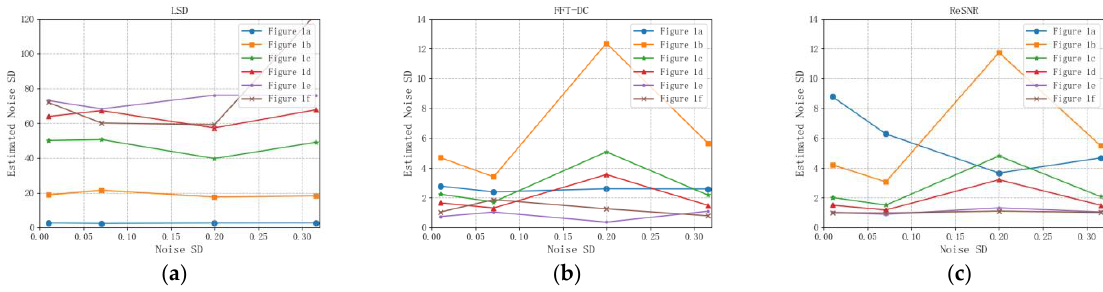
Figure 6. The results estimated by the three traditional methods in Figure 1 with different noise levels. Each curve represents the noise SD results estimated on different noise levels by an algorithm: ( a ) LSD; ( b ) FFT-DC; and ( c ) ReSNR.